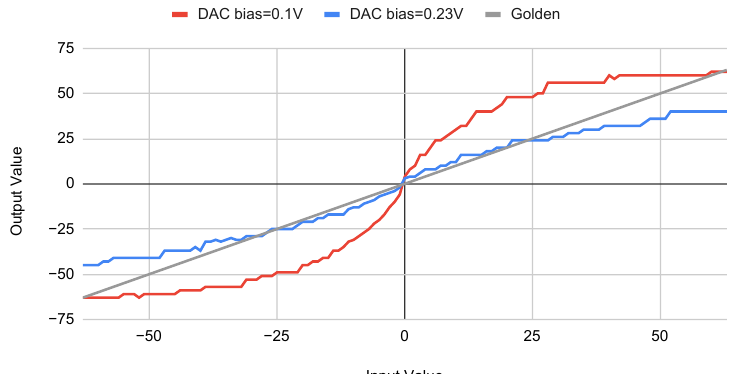
Figure 8. Difference Between